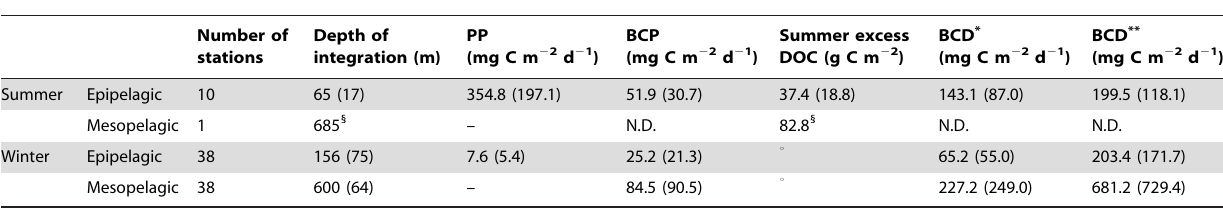
Table 1. Areal data from summer 2004 and winter 2006 cruises.